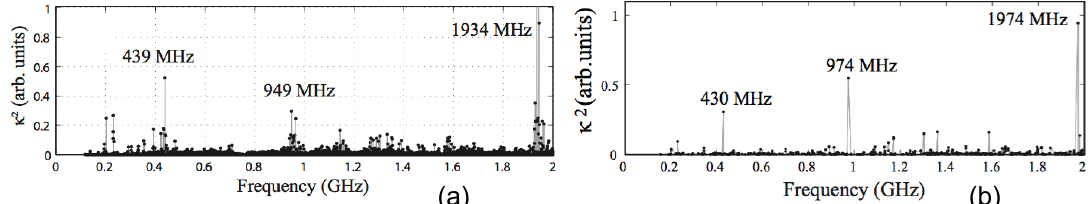
Figure 8. Finite element model (FEM)-based numerical simulation of ( a ) the elasto-optic coefficient of the PCF under test (reprinted with permission from [36], OSA) and ( b ) the elasto-optic coefficient of the perfect PCF [36] (reprinted with permission from [36],